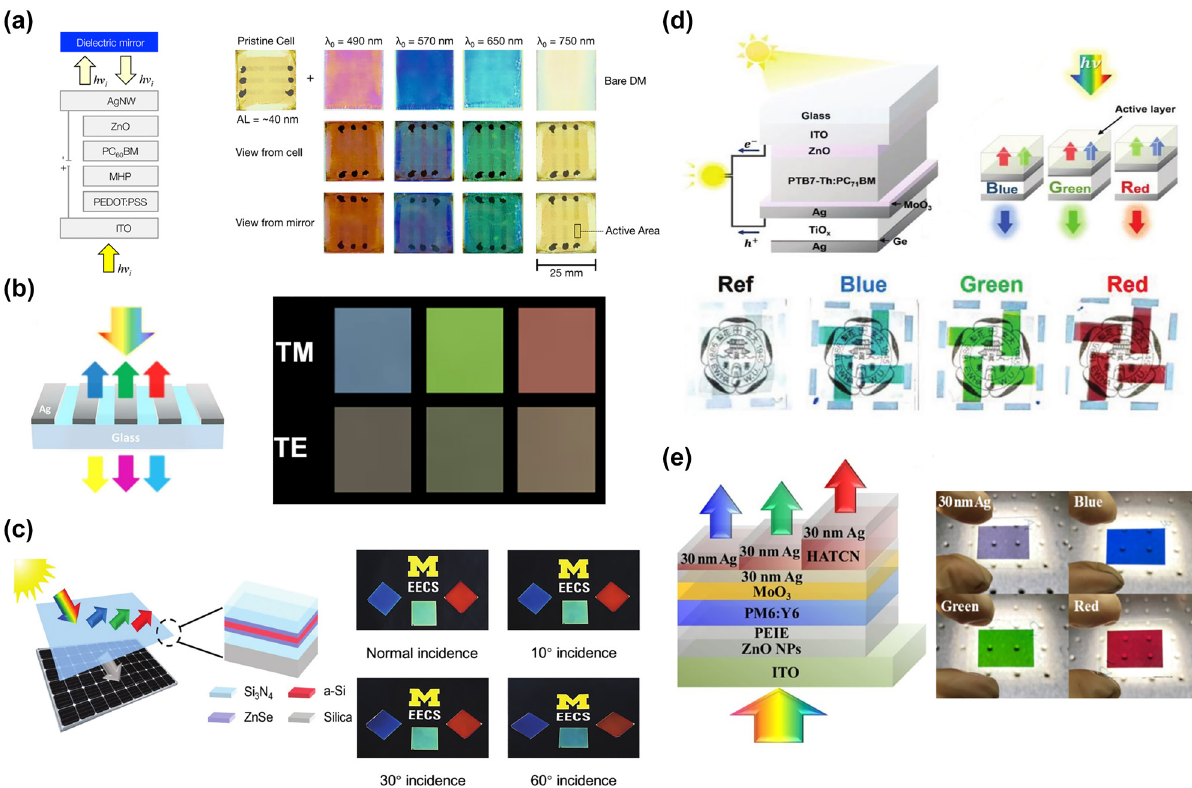
Figure 42: Colored solar cells. (a) Left panel: schematic illustration of the colored solar cell. The colors are generated by the 1D photonic crystal reflective mirror. Right panel: photos of the pristine cell, four bare dielectric mirrors (Bare DMs), and full-devices comprising both the pristine cell and reflective mirrors. Modified with permission [357]. Copyright 2016, American Chemical Society. (b) Left panel: schematic diagram of the plasmonic color filter, consisting of a subwavelength Ag grating layer atop a glass substrate. Right panel: photos of the fabricated color filters showing that the RGB reflection colors are observed only under TM polarized illumination (electric vector perpendicular to the nanograting). Modified with permission [358]. Copyright 2017, Nature Publishing Group. (c) Left panel: schematic of an improved-efficiency colored solar cell with a multilayer filter atop. Right panel: photos of the fabricated RGB filters taken at different viewing angles. Modified with permission [360]. Copyright 2019, Royal Society of Chemistry. (d) Upper panel: schematic of the organic solar cell employing a color filter electrode. Lower panel: photos of the reference transparent solar cell and three colored solar cells respectively having an RGB color filter electrode. Modified with permission [361]. Copyright 2018, Wiley-VCH. (e) Left panel: schematic of the high-efficiency organic solar cells with microcavity electrodes. Right panel: photos of the original 30 nm-thick Ag electrode and the micro-cavity (Ag/HATCN/Ag) based electrodes exhibiting RGB colors. Modified with permission [362]. Copyright 2021, Elsevier